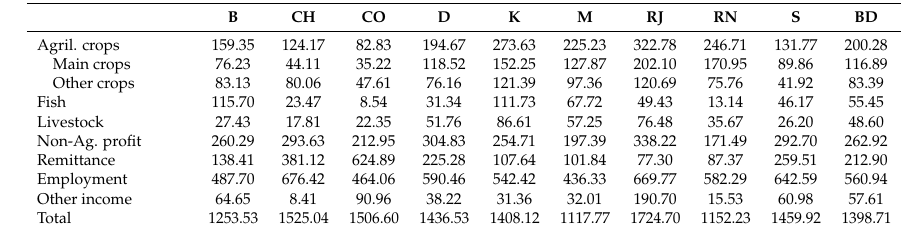
Table A1. Household income (US$/yr.) from different sources, by region. B CH